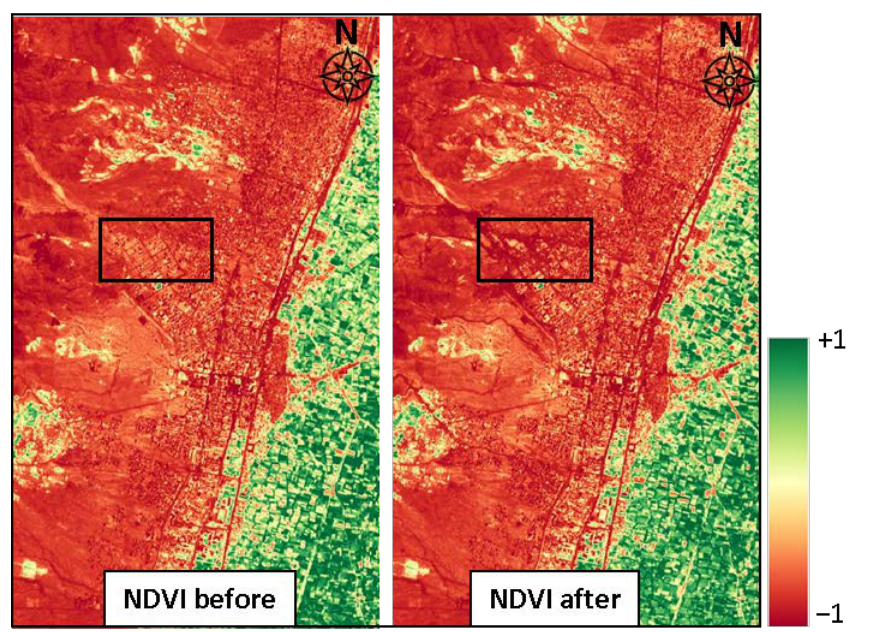
Figure 6. Observation of changes in the study area using pre- and post-event NDVIs.